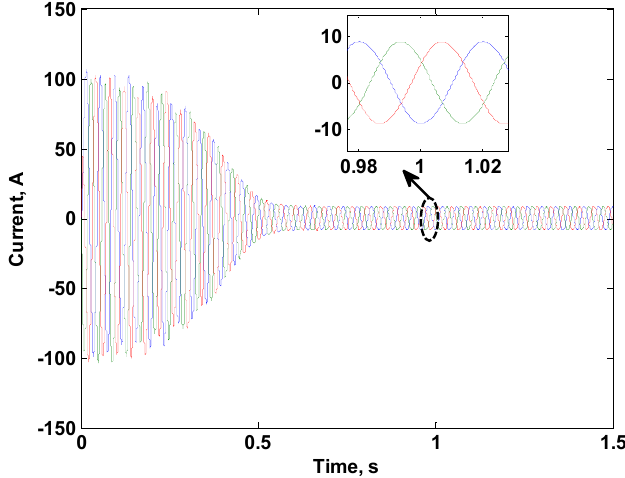
Figure 23. Three-Phase Motor Currents when Excited with 110 V, 25 Hz.